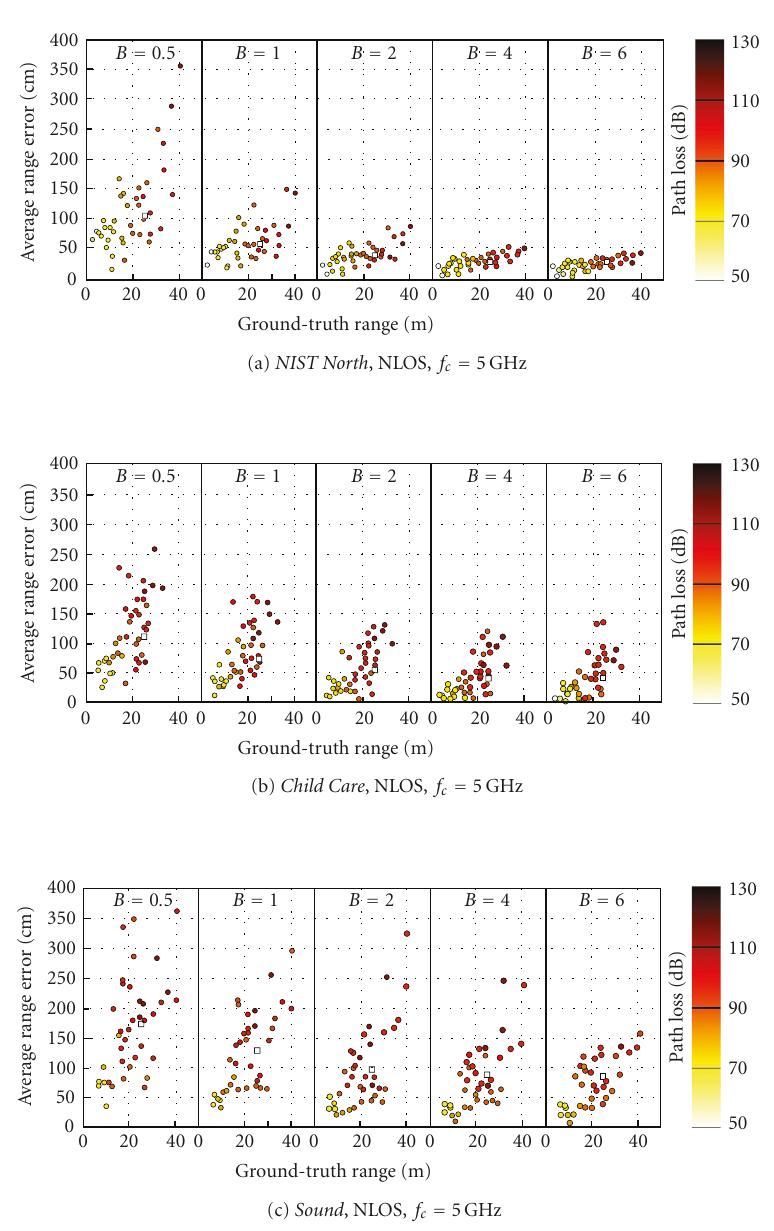
Figure 6: Range error (cm) versus ground-truth range (m) while varying bandwidth B (GHz) in nonline-of-sight